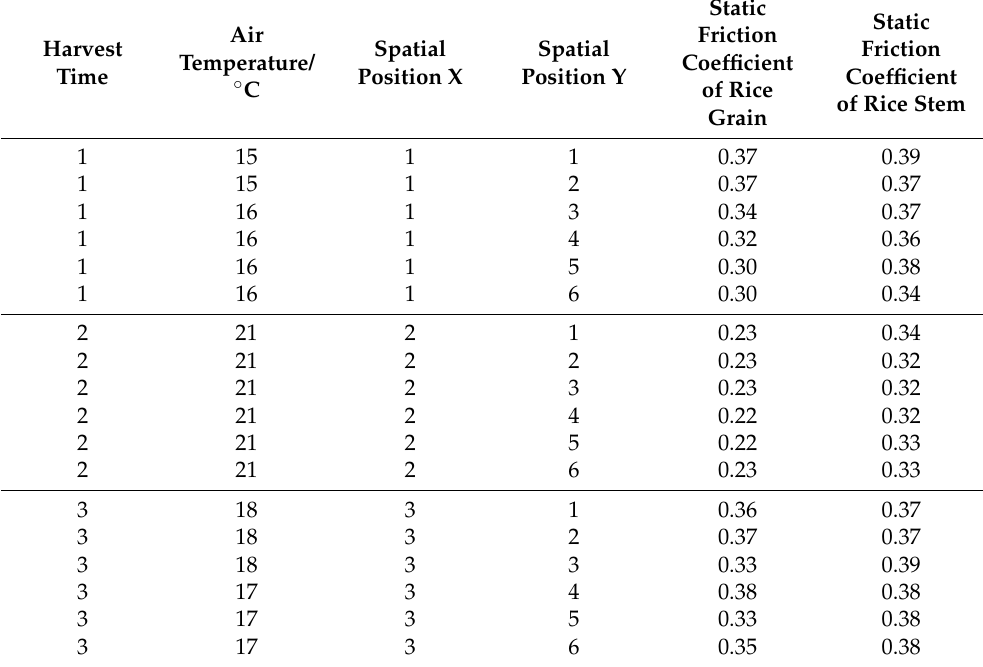
Table 2. Static friction coefficients of the rice grains and stems at different sampling points, harvest times, and air